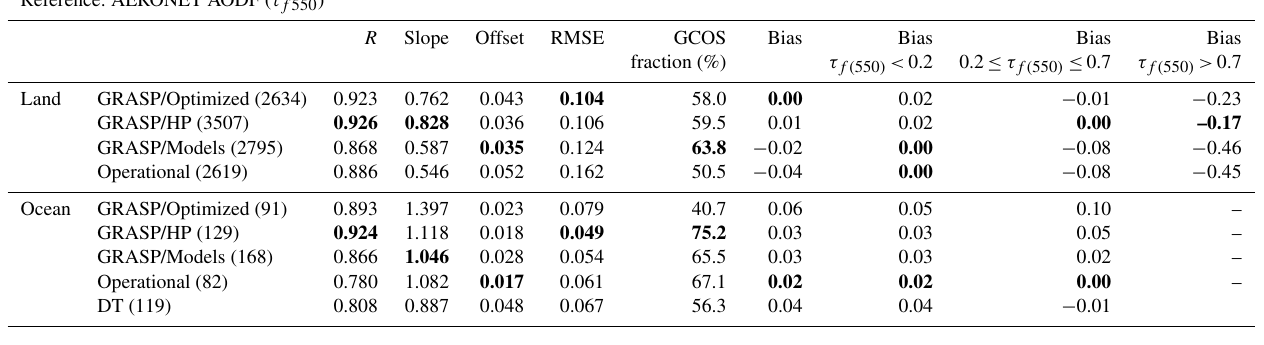
Table 12. Statistics of PARASOL and MODIS AODF products against collocated AERONET AODF over land and ocean. Reference: AERONET AODF ( τ f 550 )